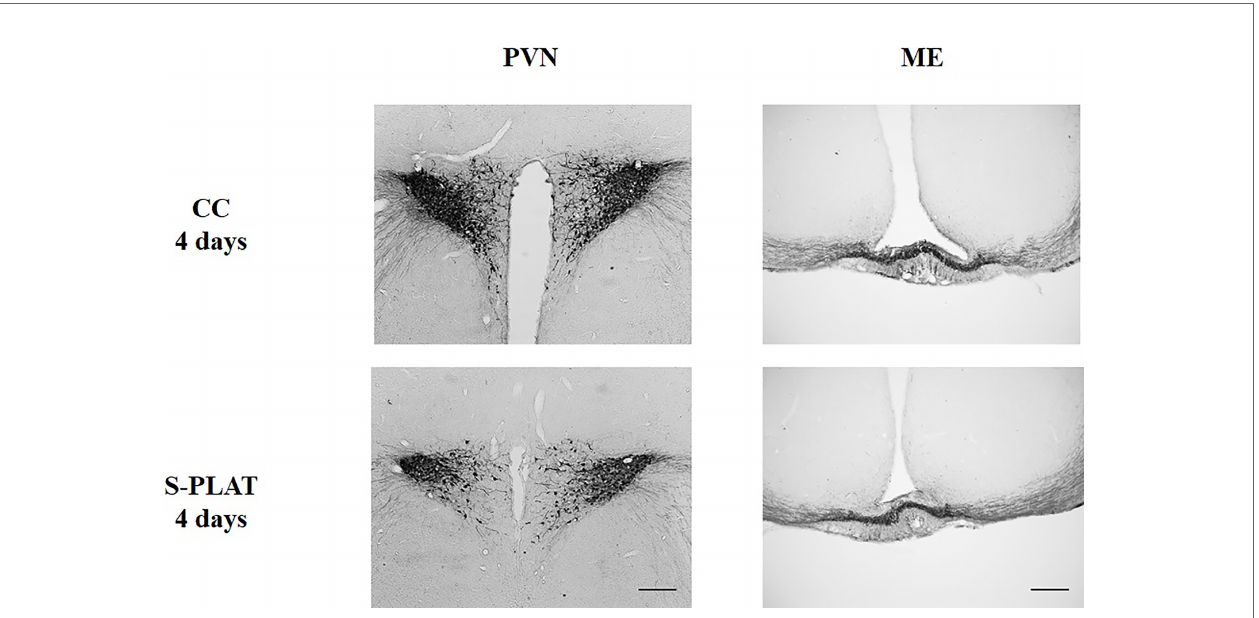
FIGURE 2 | Representative photos of AVP immunocytochemistry in the PVN (left) and in the external zone of the ME (right) of one control (CC) and one rat submitted to 4 days of paradoxical sleep deprivation (S-PLAT). Scale bar = 200 m